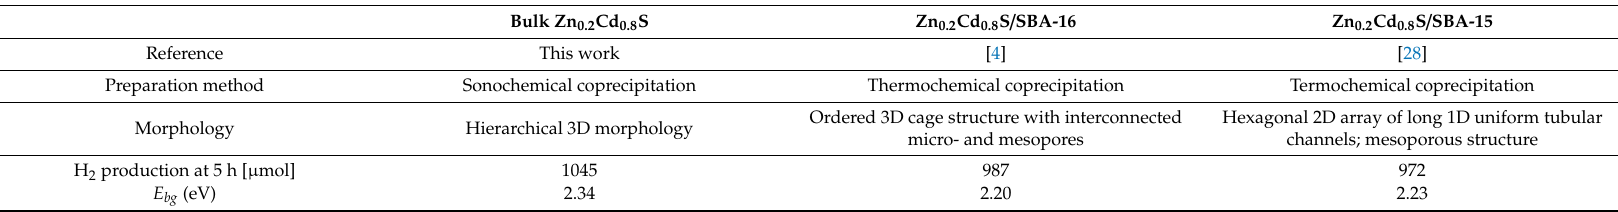
Table 3. Comparison of some characteristics of unsupported and supported Zn 0.2 Cd 0.8 S photocatalysts tested in water-splitting reaction in the same conditions a